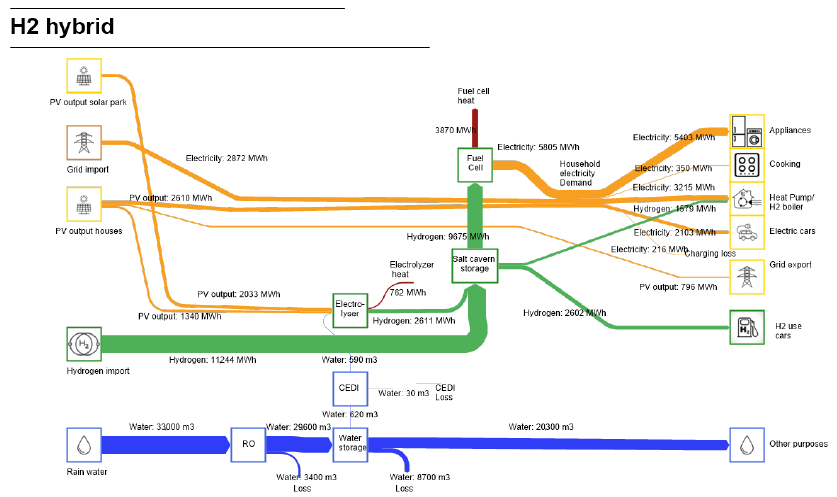
Figure 9. Sankey diagram of the yearly energy and water flows in the H 2 -hybrid system. The total heat demand (4794 MWh) is higher than in the all-electric scenarios (3935 MWh) because the houses are retrofitted to a lesser extent. Instead, one extra flow is added as hydrogen is now used in households directly for tap water and space heating in cold periods (< −5 °C), still maintaining a sufficient comfort level. Local PV production fulfills 23% (2.610 MWh) of the electricity demand, and the 1 MW el fuel cell provides 52% (5.803 MWh). As the fuel cell is smaller than in the all-electric H 2 scenario, 2.872 MWh (26%) of the electricity demand is imported from the grid. Local electricity production that could not be used directly is first converted to hydrogen (3373 MWh), and if the electrolyzer is working at full capacity, the remainder is exported to the grid (796 MWh).